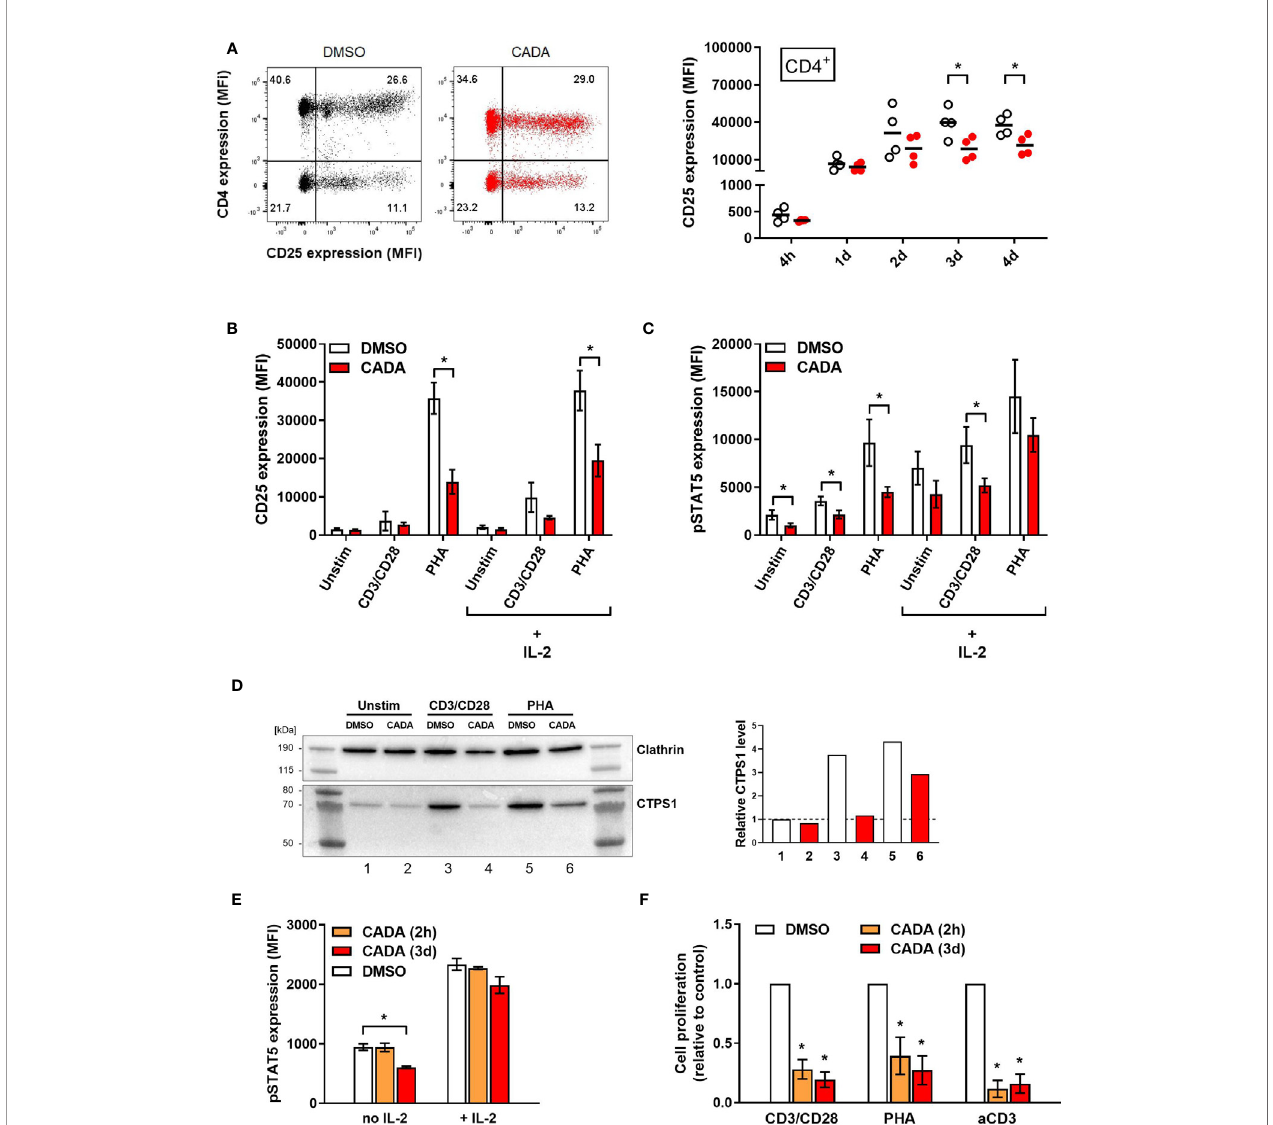
FIGURE 5 | CADA treatment results in decreased CD25 upregulation and reduced intracellular pSTAT5 and CTPS1 levels in activated PBMCs. (A) PBMCs were pre-incubated with CADA (10 m M) or DMSO for 3 days, after which they were activated with CD3/CD28 beads. Cellular surface CD25 expression was measured on gated CD4 + T cells by fl ow cytometry at 4h, 1d, 2d, 3d or 4d post activation. Representative dot plots show CD25/CD4 double staining at 1d post activation (for comparison, a dot plot at 4h is presented in Supplementary Figure 5C ). Graph shows individual MFI values of CD25 expression (acquired from at least 5,000 cells per donor) from different donors with DMSO-treated cells as open symbols and CADA-treated cells as solid red dots. A paired t-test was performed to compare CADA to DMSO with *p<0.05. Horizontal lines indicate the mean values of 4 different donors (n=4). (B – D) PBMCs were pre-incubated with CADA or DMSO for 3 days, after which they were left unstimulated or were activated with CD3/CD28 beads or PHA. (B, C) At day 2, half of the samples were boosted with IL-2. Cell surface CD25 receptor (B) and intracellular pSTAT5 (C) expression were simultaneously measured by fl ow cytometry. Bar diagrams are showing the MFI values for CD25 and pSTAT5 (mean ± SD). Multiple t-tests were performed to compare CADA (red bars) to DMSO (white bars) for each condition with *p<0.05 and with Holm- Sidak method as correction for multiple comparison. Data were collected from four different donors (n=4). (D) At day 2 post activation, cells were lysed and CTPS1 expression was detected by western blotting. Clathrin was used as protein loading control. Graph shows quanti fi cation of protein bands, normalized to the clathrin internal control. Normalized CTPS1 level of unstimulated DMSO control was set as 1. (E) PBMCs were pre-incubated with CADA or DMSO for 2 hours (2h) or for 3 days (3d), and subsequently left unstimulated (no IL-2) or boosted with exogenous IL-2 (+ IL-2). After 15 minutes, intracellular pSTAT5 expression was measured by fl ow cytometry. Bar diagrams are showing the MFI for pSTAT5 (acquired from at least 5,000 cells per donor), with DMSO in white and CADA in orange or red. Welch ’ s corrected t-tests were performed to compare CADA to DMSO with *p<0.05. Values represent mean ± SD of two different donors (n=2). (F) PBMCs were pre-incubated with CADA or DMSO for 2 hours (2h) or for 3 days (3d), and subsequently activated with CD3/CD28 beads, PHA or anti-CD3 antibodies. At 24h